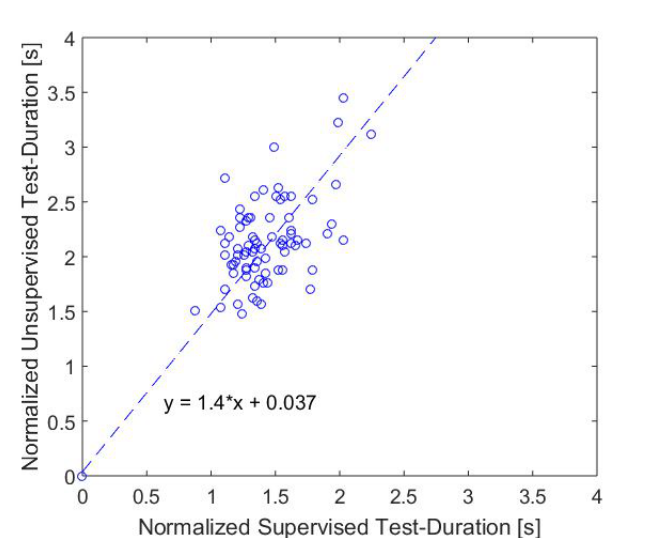
Figure 11. Comparison of the normalized durations of the TUG-test and the semi-unsupervised test situation.